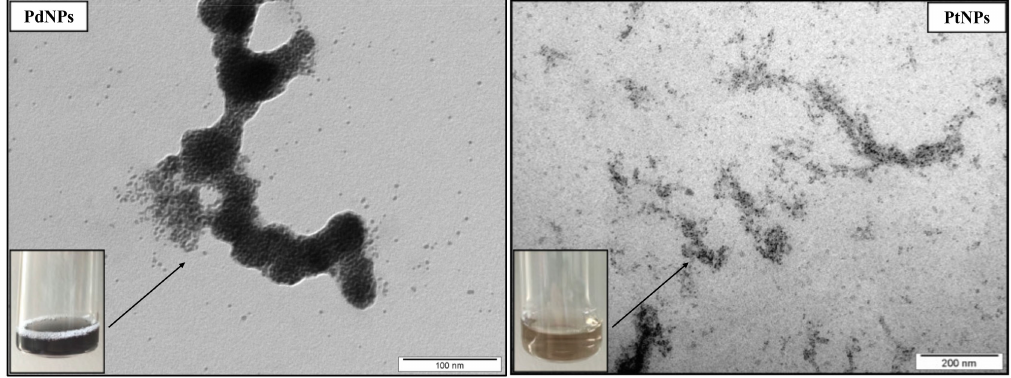
Figure 4. TEM images of palladium nanoparticles (PdNPs) and platinum nanoparticles